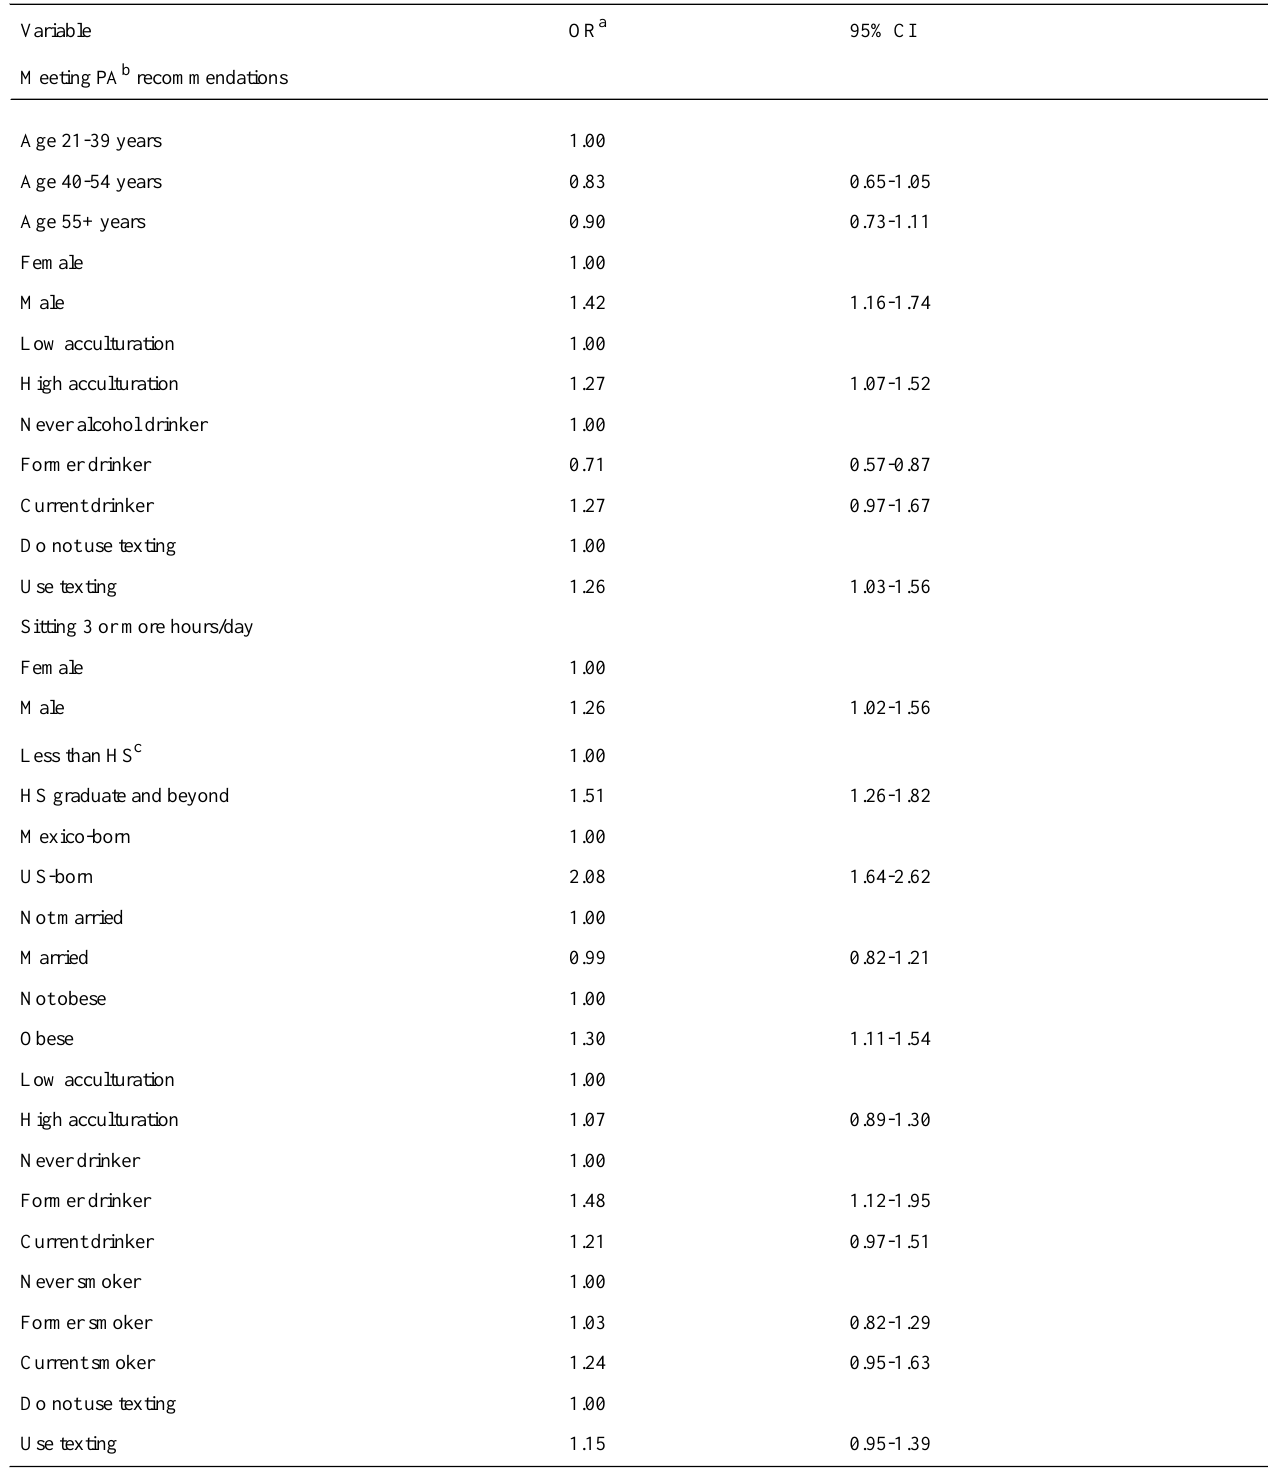
Table 4. Multivariate adjusted odds ratios (95% CI) of mobile phone users for meeting physical activity recommendations and sitting 3 or more